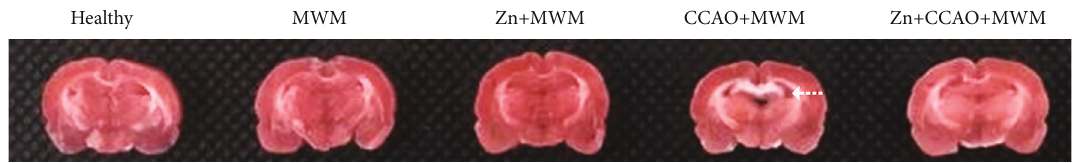
Figure 6: The subacute prophylactic zinc administration and swimming prevented tissue damage induced by 30min CCAO in the hippocampus, as revealed by TTC staining. Slices of 2 mm thickness from fresh brains were stained with 2,3,5-triphenyltetrazolium chloride (TTC). Images representative of 3 brains per group. The white arrows indicate the infarct zones in the hippocampus. The arrow indicates the infarct